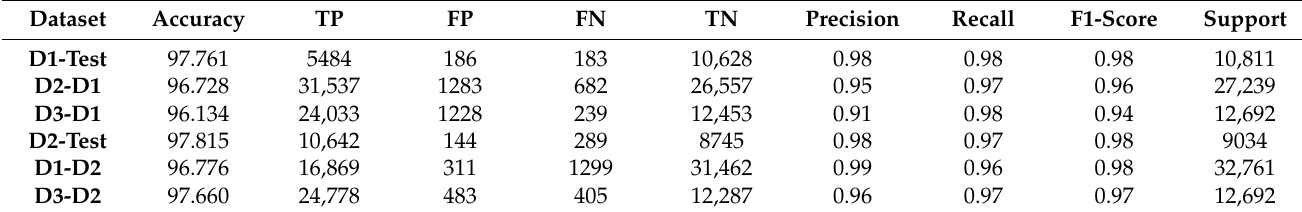
Table 7. Results of Random Forest ML